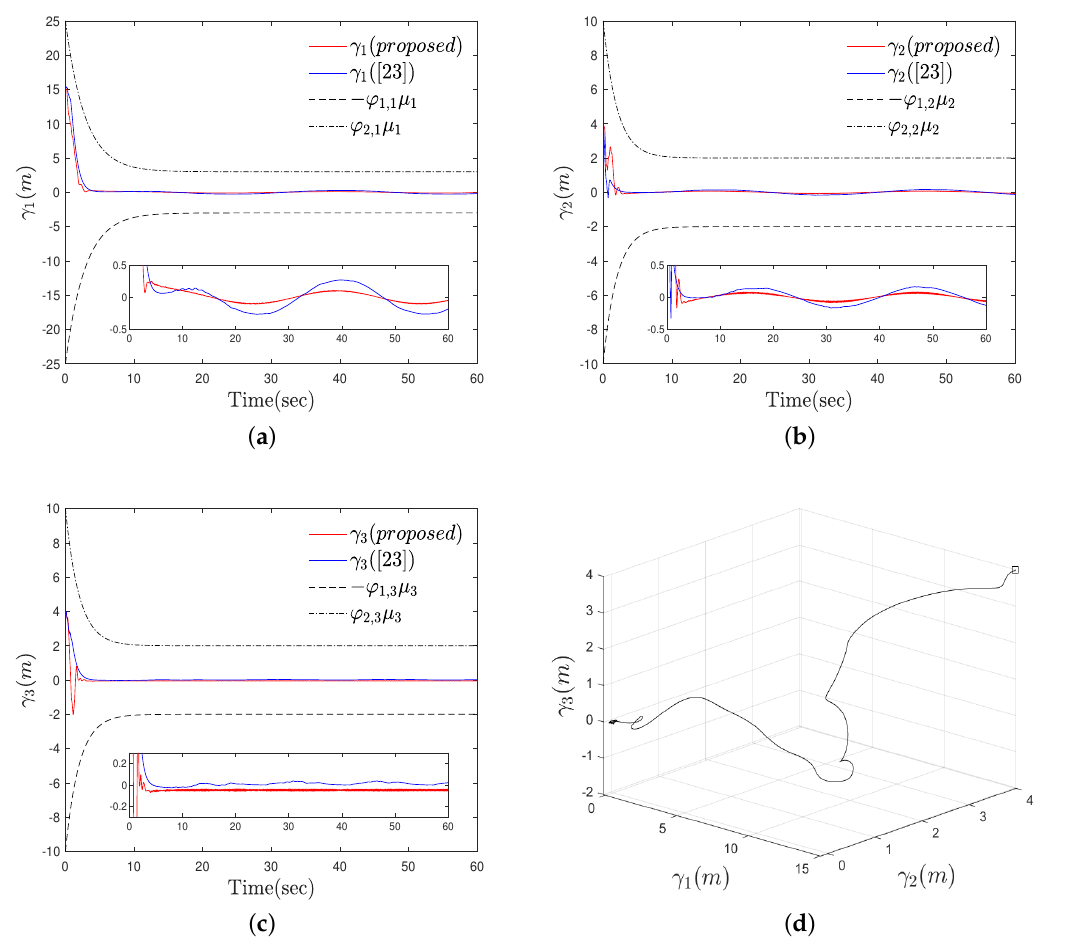
Figure 9. Tracking errors and error phase portraits of the proposed approach for Scenario 2 ( a ) comparison of γ 1 of the proposed approach and the previous approach [23] ( b ) comparison of γ 2 of the proposed approach and the previous approach [23] ( c ) comparison of γ 3 of the proposed approach and the previous approach [23] ( d ) phase portrait of γ 1 , γ 2 , and γ 3 of the proposed